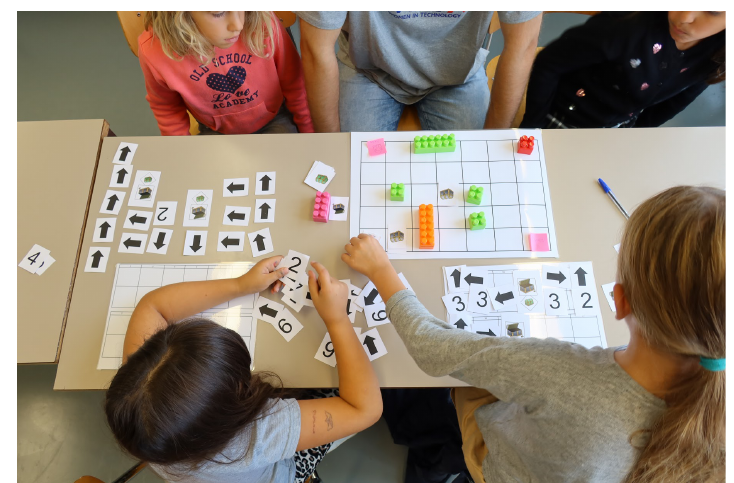
Figure 1. "Introduction to Programming" workshop in action